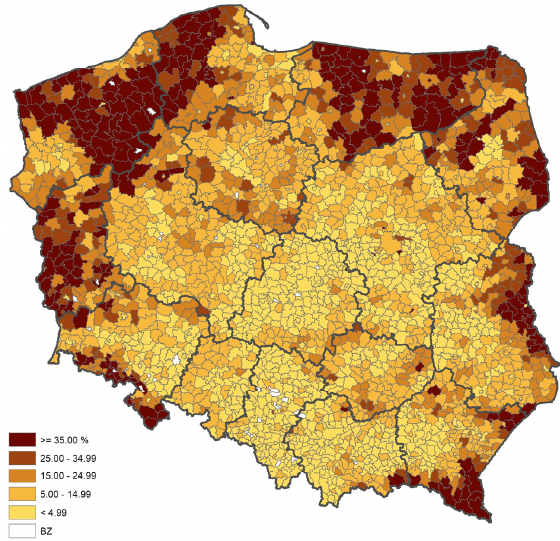
Figure 2. Structural types of pro-environment activity of agricultural farms. Source: developed by the authors, based on ARMA data (description as in Table